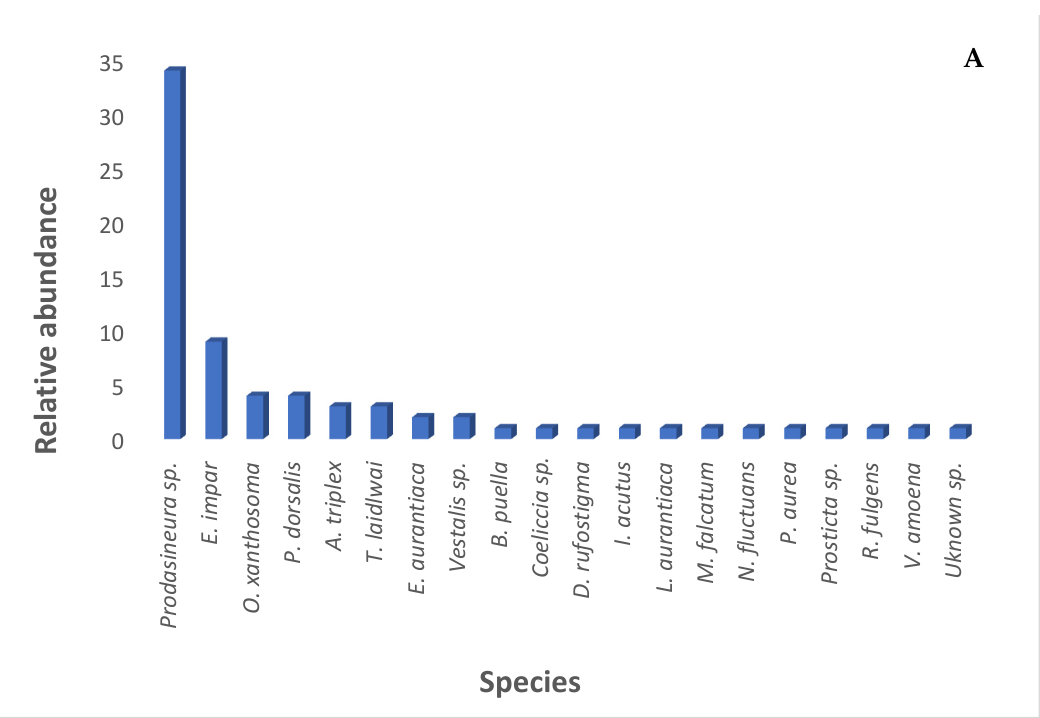
Figure A1. A photo plate of a few sampled species: ( A ) Amphicnemis triplex (male) ( B ) Rhyothemis obsolescens (male), ( C ) Vestalis amoena (male), ( D ) Pachycypha aurea (female), ( E ) Neurothemis fluctuans (male), ( F ) Ceriagrion sp .; one of the two species of damselfly captured in low pole peat swamp and present in high abundance, and which is potentially new to science.